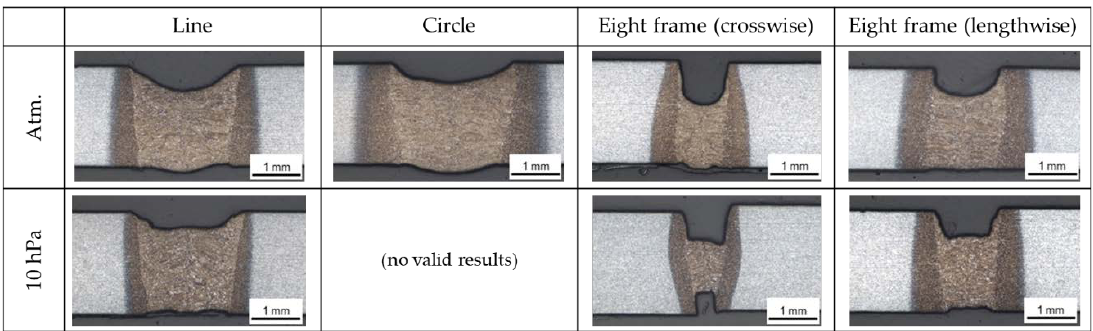
Figure 10. Macrographs of specimens prepared with a 0.4 mm gap, welded using different oscillation patterns at atmospheric pressure and 10 hPa.